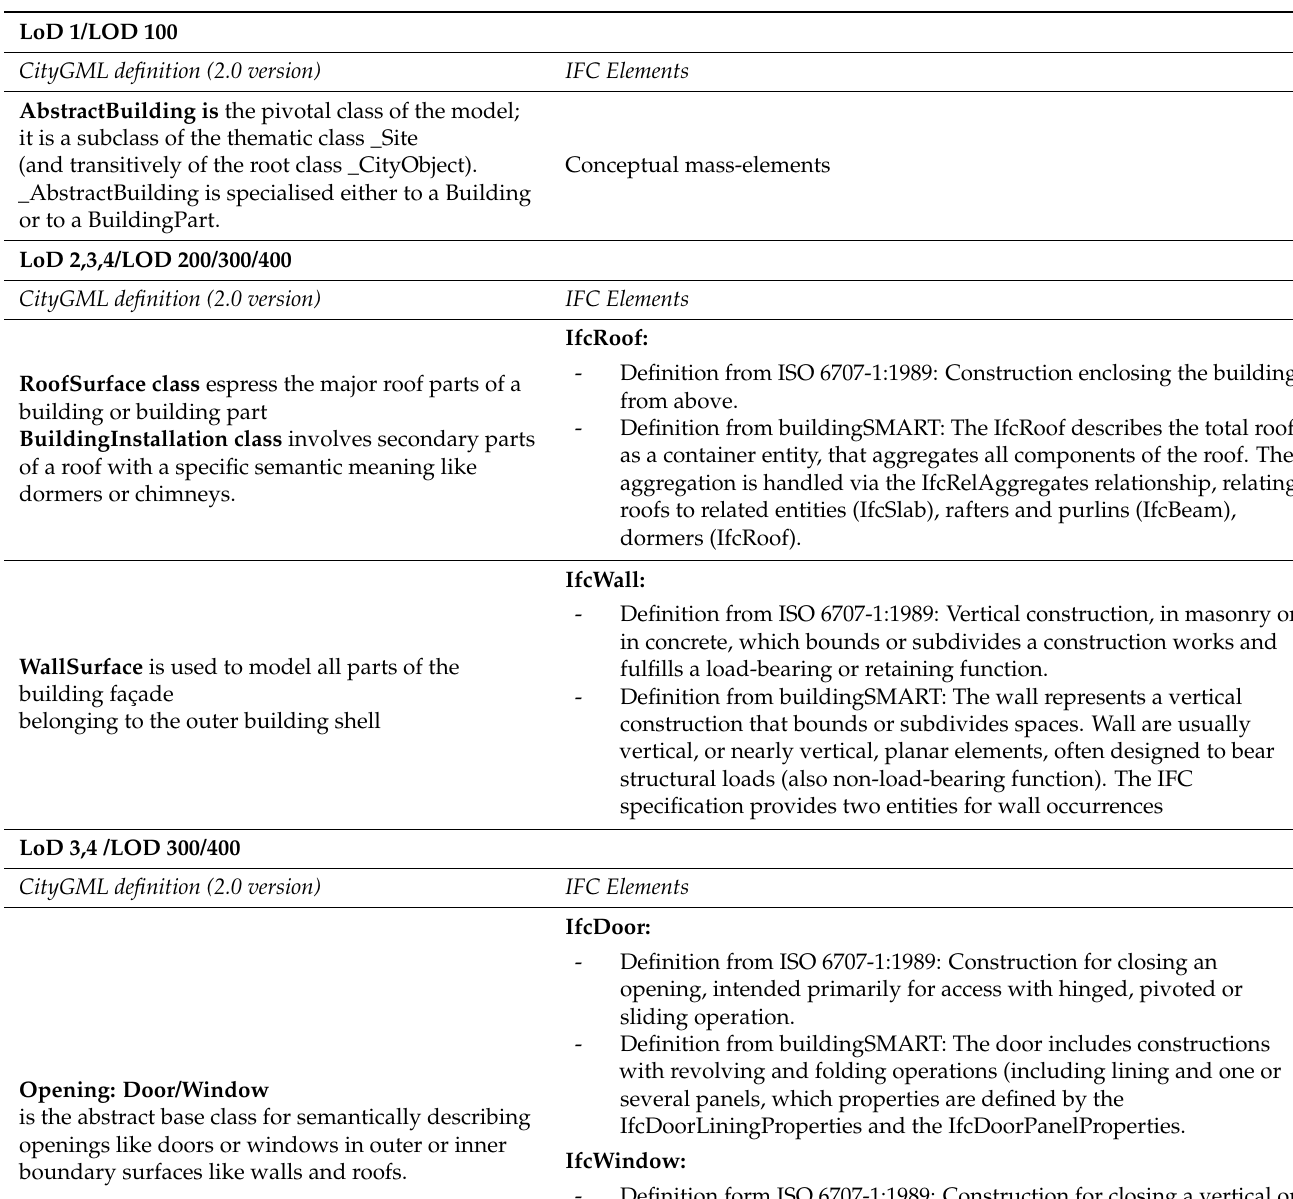
Table 3. Comparison between LoD/LOD in CityGML and